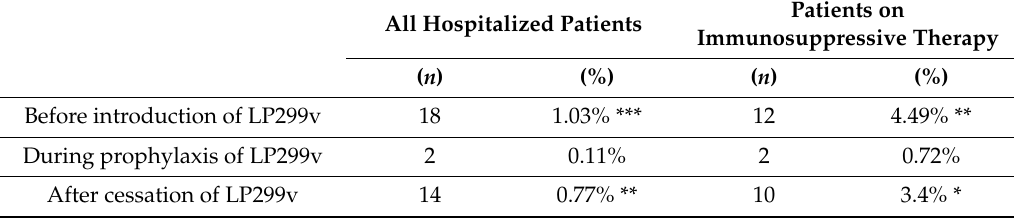
Table 3. The number of CDI cases and incidence before, during and after cessation of LP299v administration as a routine prophylaxis in the nephrology and transplantation ward among all patients and patients during immunosuppressive therapy hospitalized in the nephrology and transplantation ward.